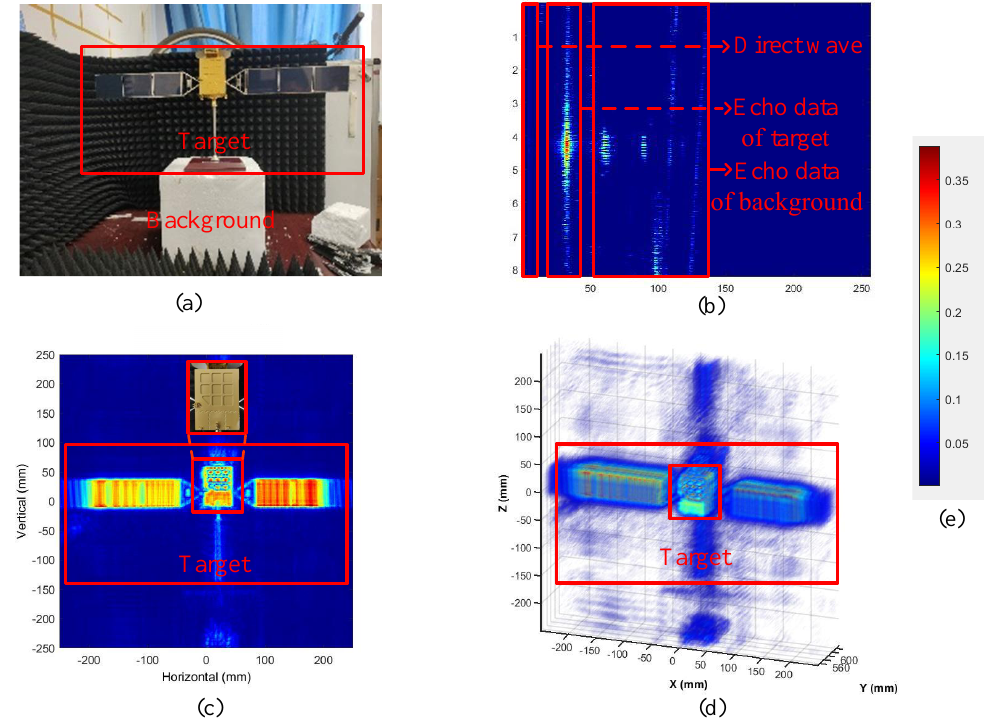
Figure 6. Data processing results. ( a ) is the optical image; ( b ) is the image with pulse compression; ( c ) is the 2-D imaging result; ( d ) is the 3-D imaging result; ( e ) is the color